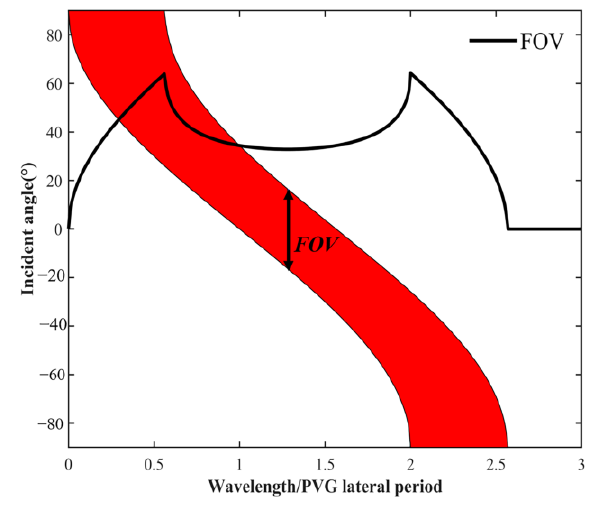
Figure 2. The curve of FOV and λ Λ